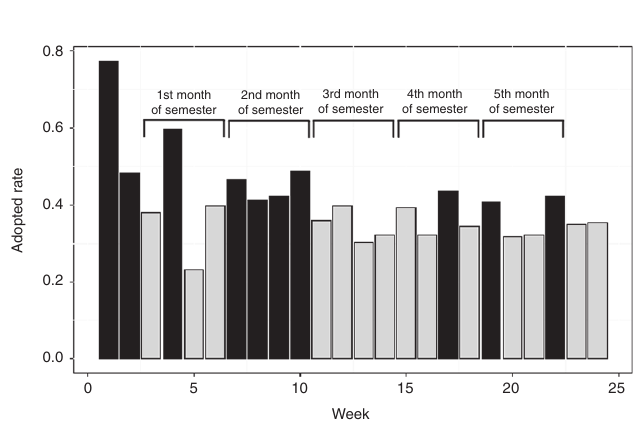
Figure 6. Adopted rate for study weeks (features) in case